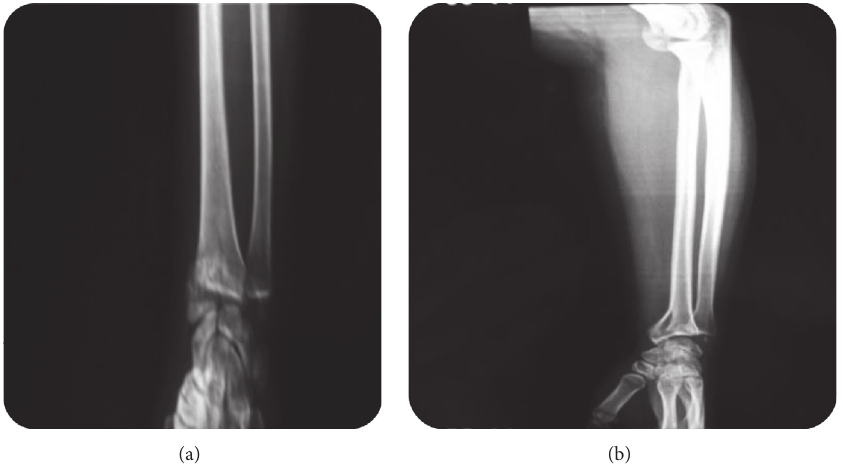
Figure 2: (a) Anteroposterior and (b) lateral radiographs showing comminuted articular fracture of the distal radius with an anterior